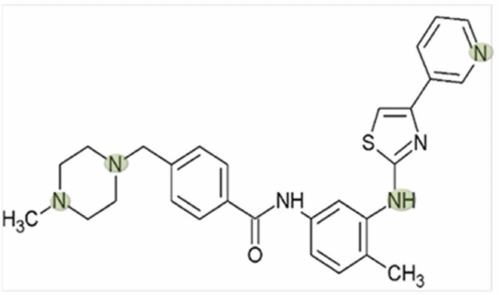
Figure 1. Structure of the TKI masitinib compiled using the ACD/ChemSketch program (Toronto, Canada). The marks (green) indicate predicted protonated sites in the molecule at pH